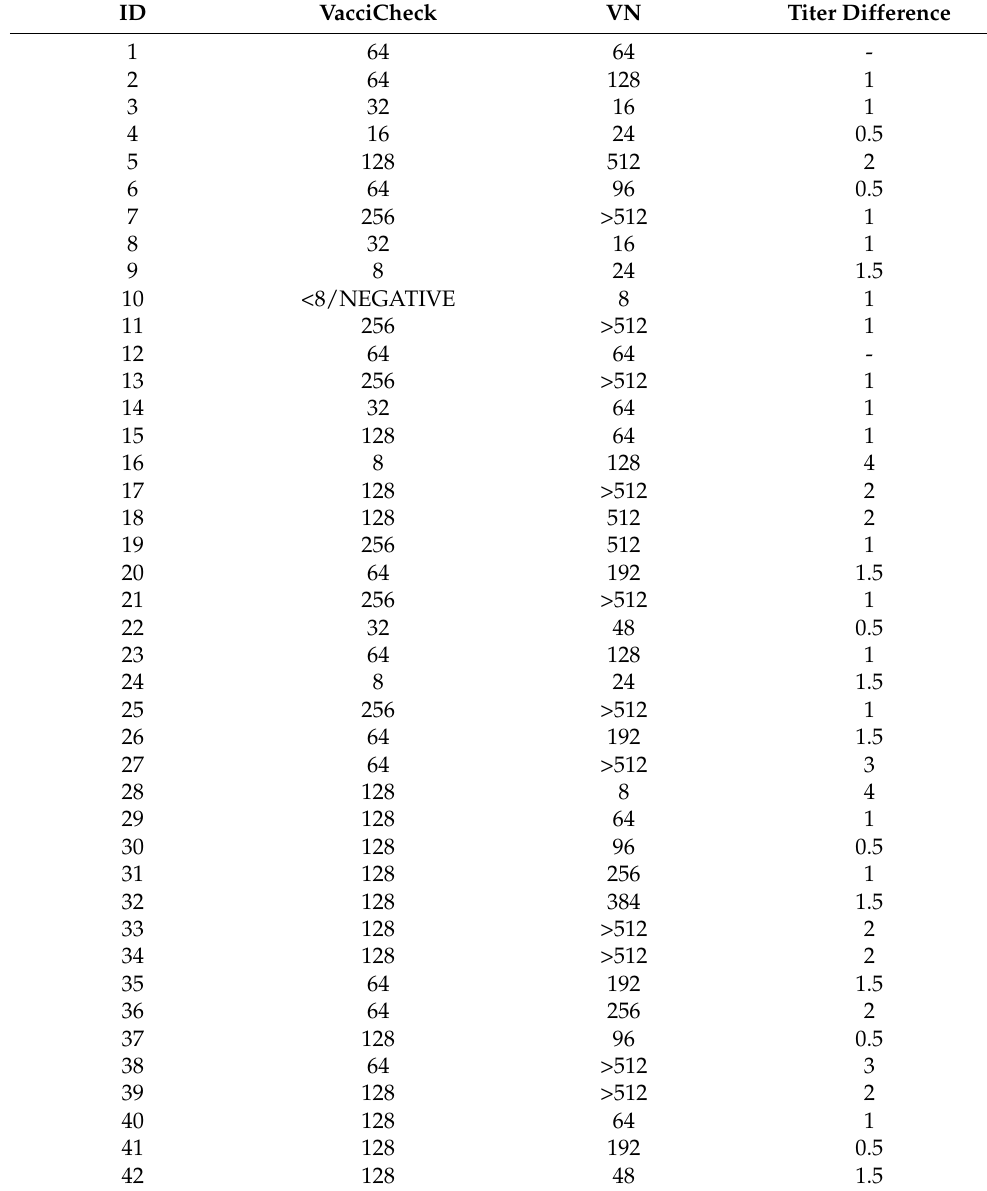
Table 2. Results obtained for each sample for both VacciCheck and